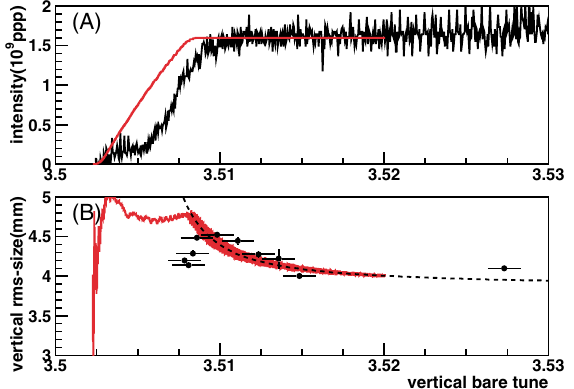
FIG. 7. (Color) Beam intensity (a) and vertical rms beam size (b) when the resonance line was crossed downward. In (a), the black and red solid lines show experimental and simulation results, respectively. The black circles and the red line in (b) show the results from an experiment and a multiparticle simulation, respectively, and the dashed line shows the matched solution of the envelope equation.